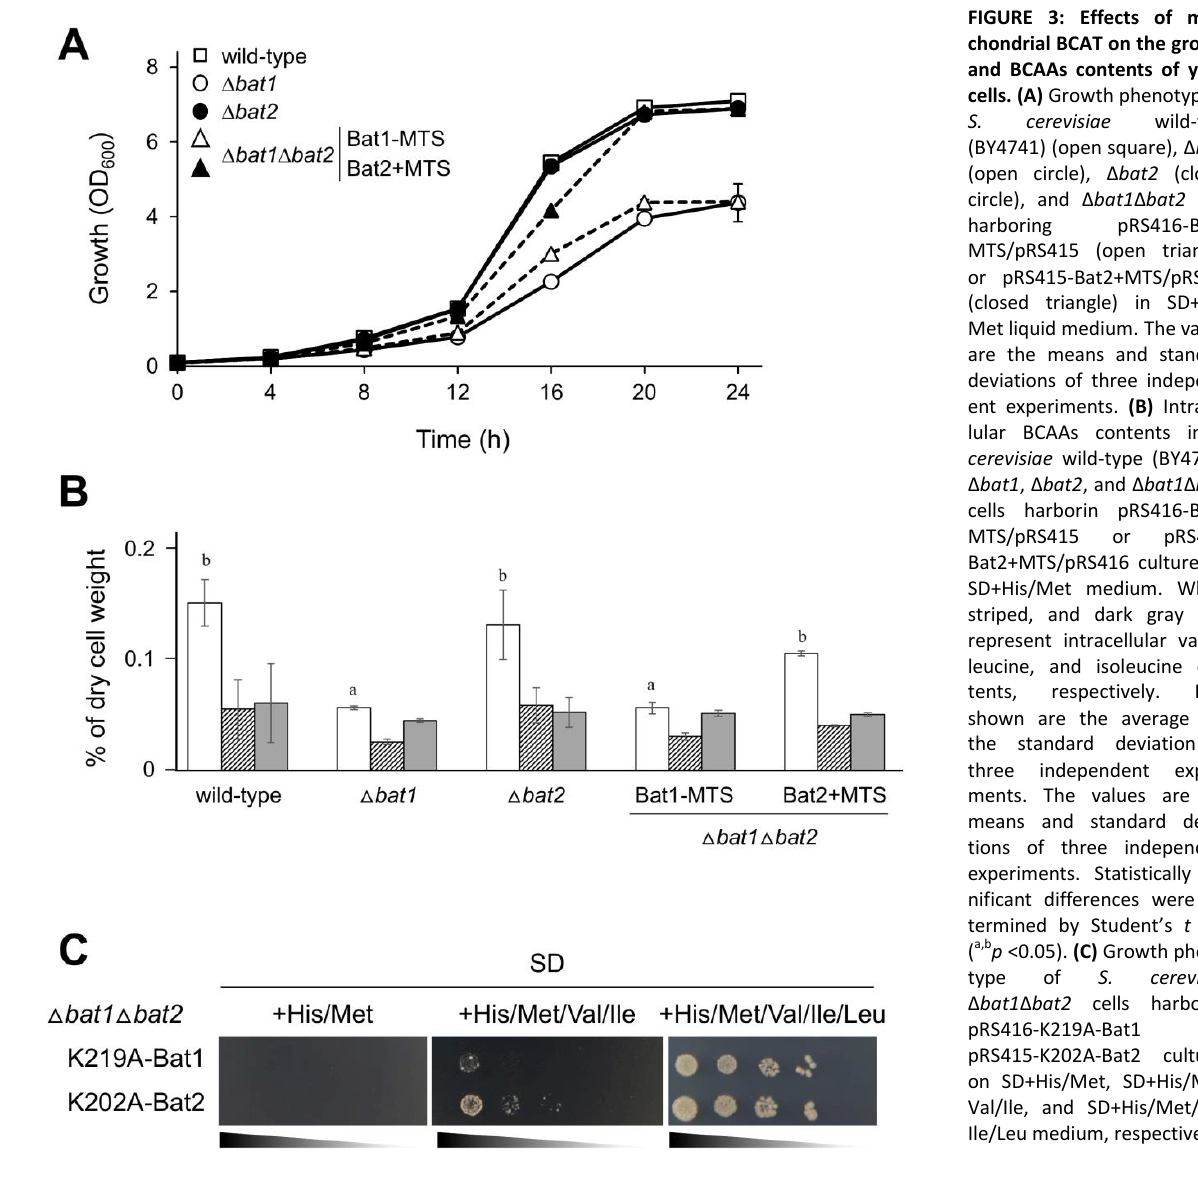
FIGURE 3: Effects of mito- chondrial BCAT on the